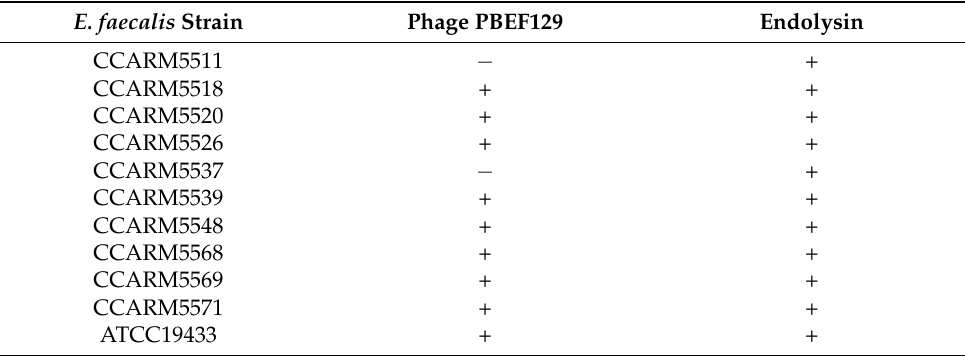
Figure 3. Characterization of antibacterial activity of the endolysin on live bacterial cells. ( A ) Optimal pH of the antibacterial activity of the endolysin. Buffer containing each pH was used for incubation of the antibacterial reaction with 4.8 μ M of protein and 1-hour incubation. ( B ) Antibacterial efficacy was shown in a dose-dependent manner. Log reduction of bacterial count is shown with the amount of protein used indicated. Assay mixture at pH 7.5 was incubated at 37 °C for 2 or 4 hours. Table 2. Lysis of E. faecalis strain by phage vs. endolysin.